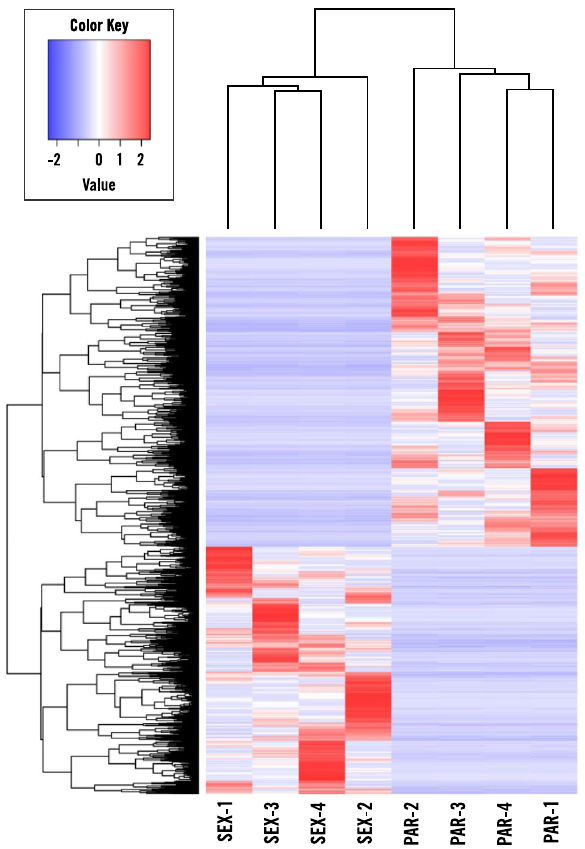
Figure 5. Heatmap of TPM value of DE transcripts. This plot represents every DE transcript (SEX vs PAR) with rows representing each transcript and relative expression (low in blue and high in